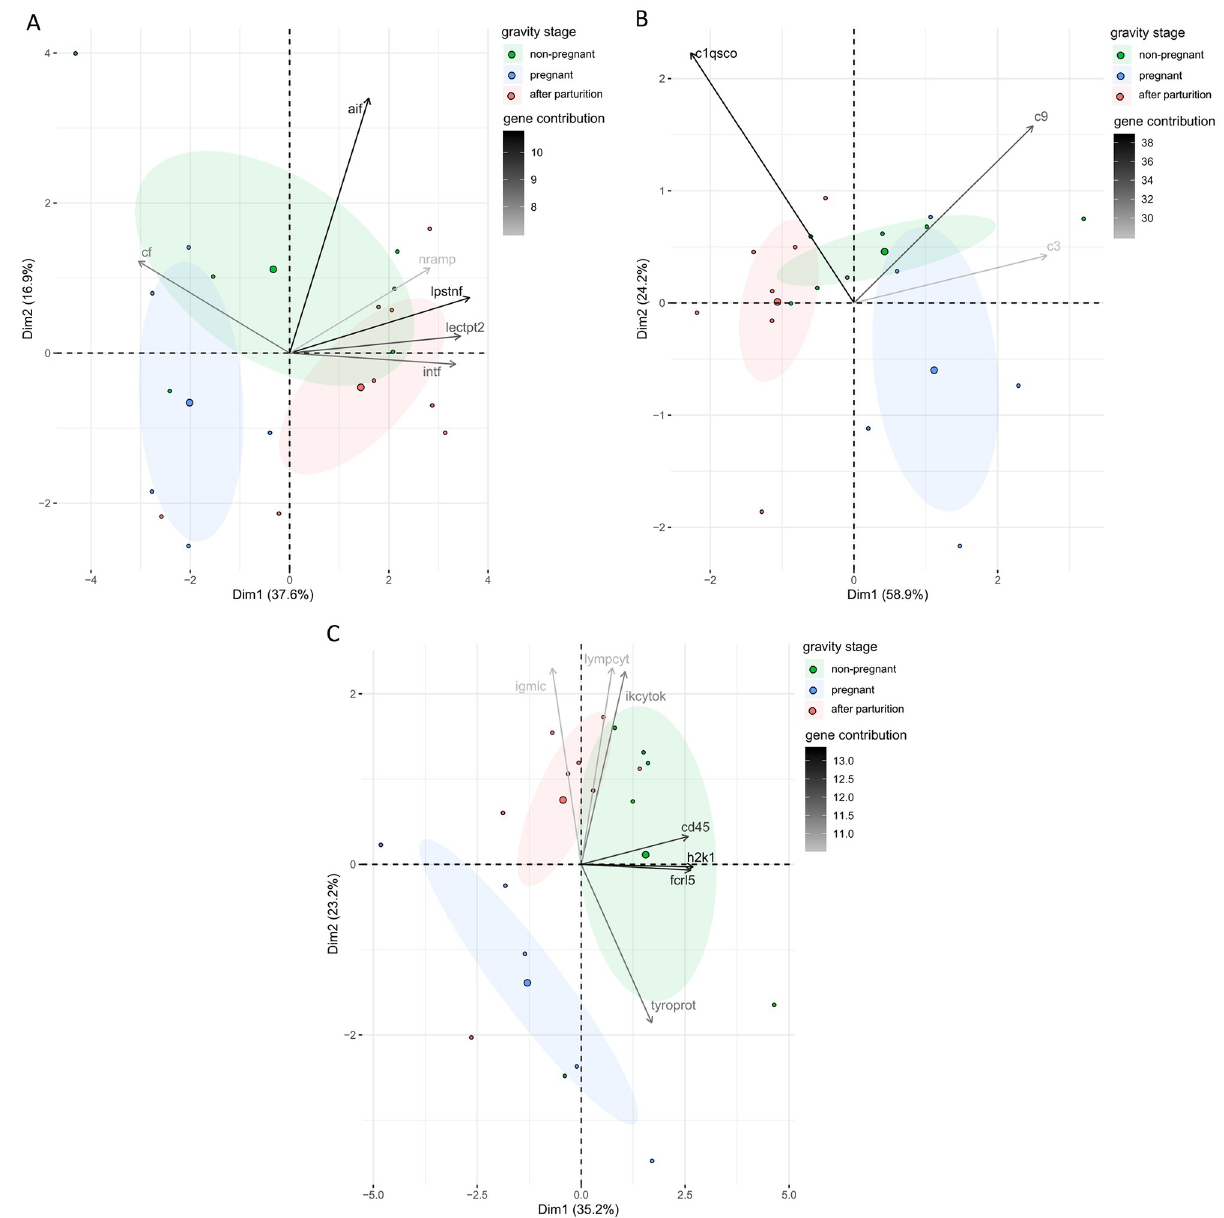
Fig 3. Principal component analysis (PCA) of effects of male gravity stage on gene expression in S . typhle . The first two principal components, PC1 explaining 37.6% of the total variance and PC2 explaining 16.8% of the total variance, are shown with 95% confidence ellipses (shaded area) around a center of gravity (big points). Samples are indicated as small points. Colors represent male gravity stages; green for non-pregnant males, blue for pregnant males and red for males after parturition. ( A ) PCA of effects of male gravity stage on innate immune system genes. Shading of the arrows shows contributions of the genes with a contribution to the principal components higher than expected. (B) PCA of effects of male gravity stage on complement component genes. Shading of the arrows shows contributions of the depicted genes to the principal components. (C) PCA of effect of male gravity stage on adaptive immune system genes. Shading of the arrows shows contributions of the genes with a contribution to the principal components higher than expected.